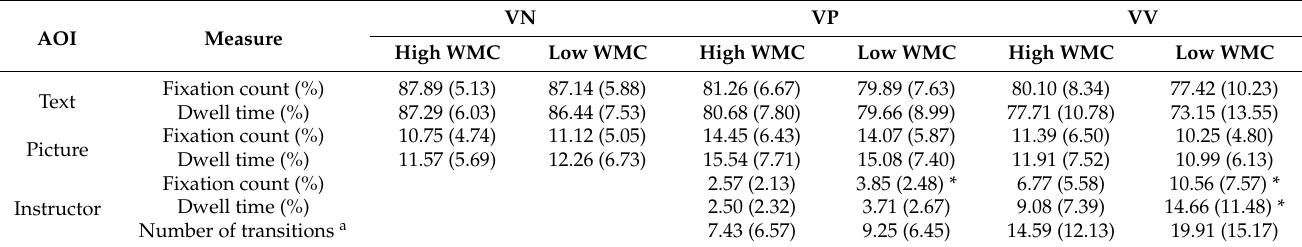
Table 2. Visual attention distribution statistics for the three types of video